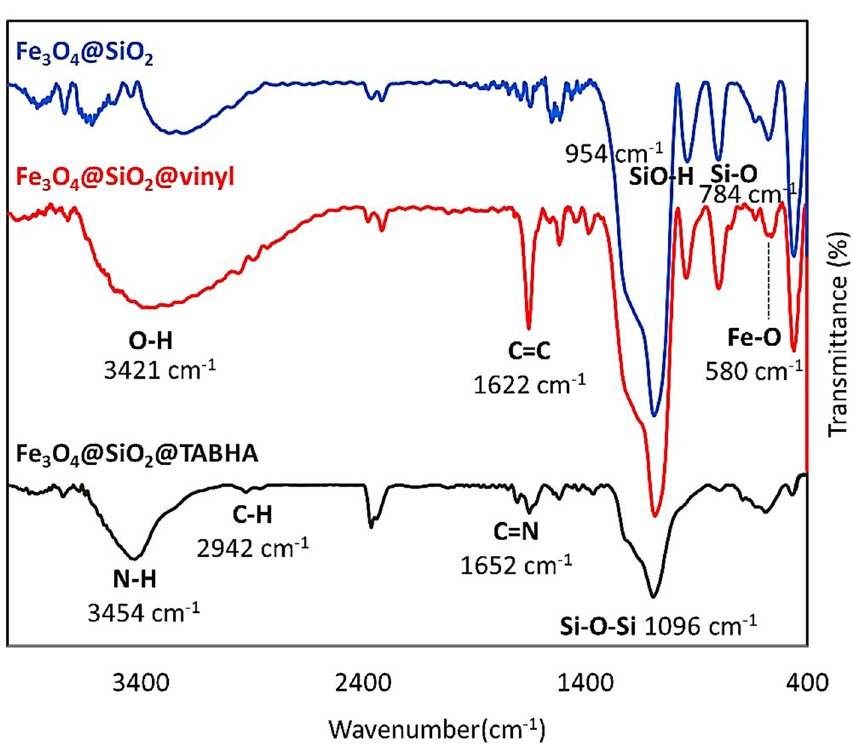
Figure 2. The FTIR spectra of Fe 3 O 4 @SiO 2 (blue), Fe 3 O 4 @SiO 2 @vinyl (red), and Fe 3 O 4 @SiO 2 /TABHA nanoparticle